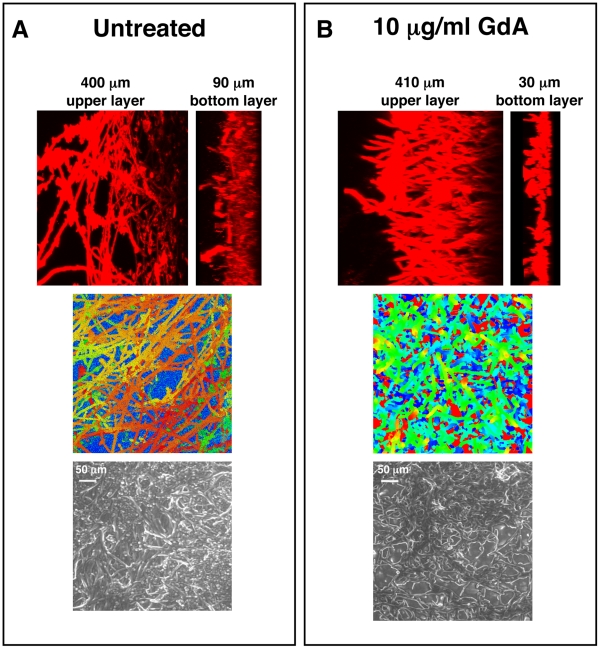
Pharmacological inhibition of Hsp90 alters C. albicans biofilms architecture.
C. albicans cells were grown on silicon elastomer squares in RPMI at 37°C for 24 hours. C. albicans wild-type biofilms were left untreated (A), or treated with 10 µg/mL geldanamycin (GdA) for 48 hours (B). Biofilms were stained with concanavalin A conjugate for confocal scanning laser microscopy visualization, and image reconstructions were created to provide side views (top panel). Representative images are shown. Confocal scanning laser microscopy depth views were artificially coloured (middle panel) with blue representing within 10 µm from the silicon, orange representing approximately 300 µm from the silicon, and red representing over 400 µm from the silicon. Scanning electron microscopy images are shown in bottom panel. Biofilms treated with GdA show a thinner lower layer of yeast than the untreated control.